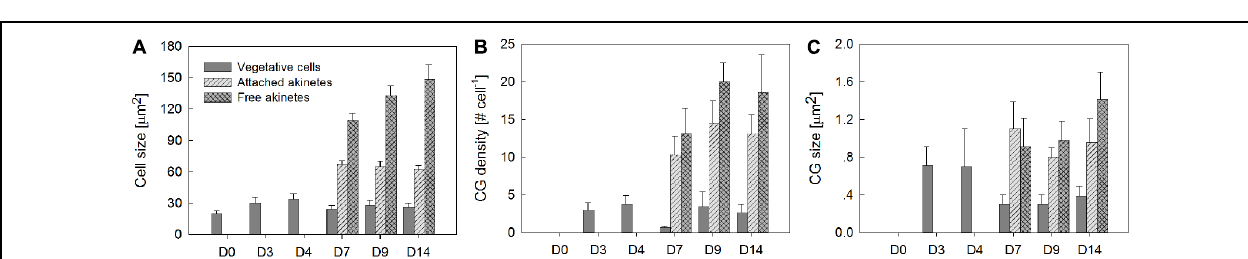
FIGURE 3 | Quantitative data of cell size (A), cellular abundance of cyanophycin globule (B) and the size of cyanophycin globule (C) in vegetative cells and akinetes (filament-attached and -free) in A. ovalisporum incubated under akinete-inducing conditions. Samples collected at different times during the induction (D0, D4, D7, D9, and D14, represent sampling days) were stained by Sakaguchi reaction and CG became dark visible (as presented in Figure 2 ). Data was collected by analyzing microscopic images using ImageJ, image-processing program. Bars present average and standard deviation. For each time point and cell type at least 40 individual objects were